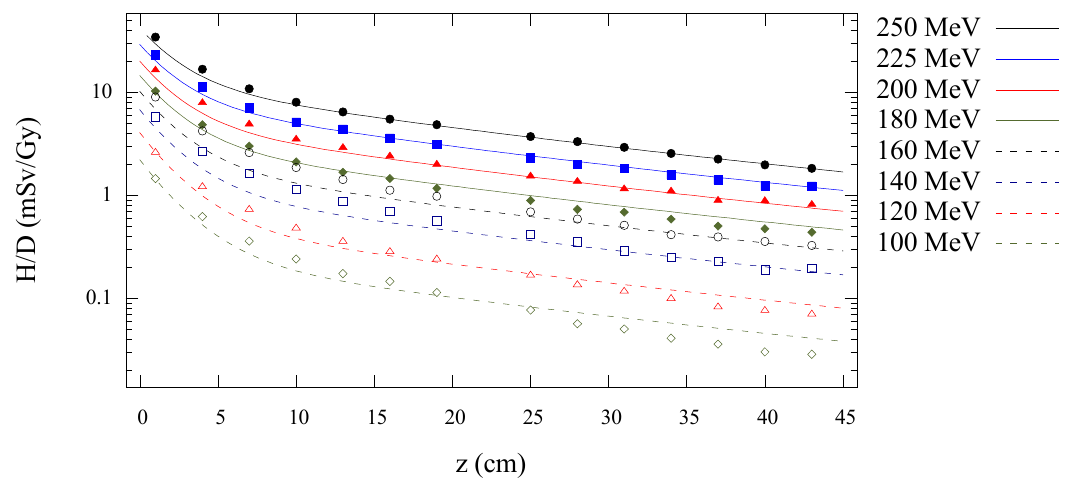
Figure 5. Predictions from Monte Carlo (points) and analytical model (lines) of neutron equivalent dose per treatment dose (𝐻/𝐷) versus depth in water at 10 cm off-axis for 100 to 250 MeV proton beam energies.